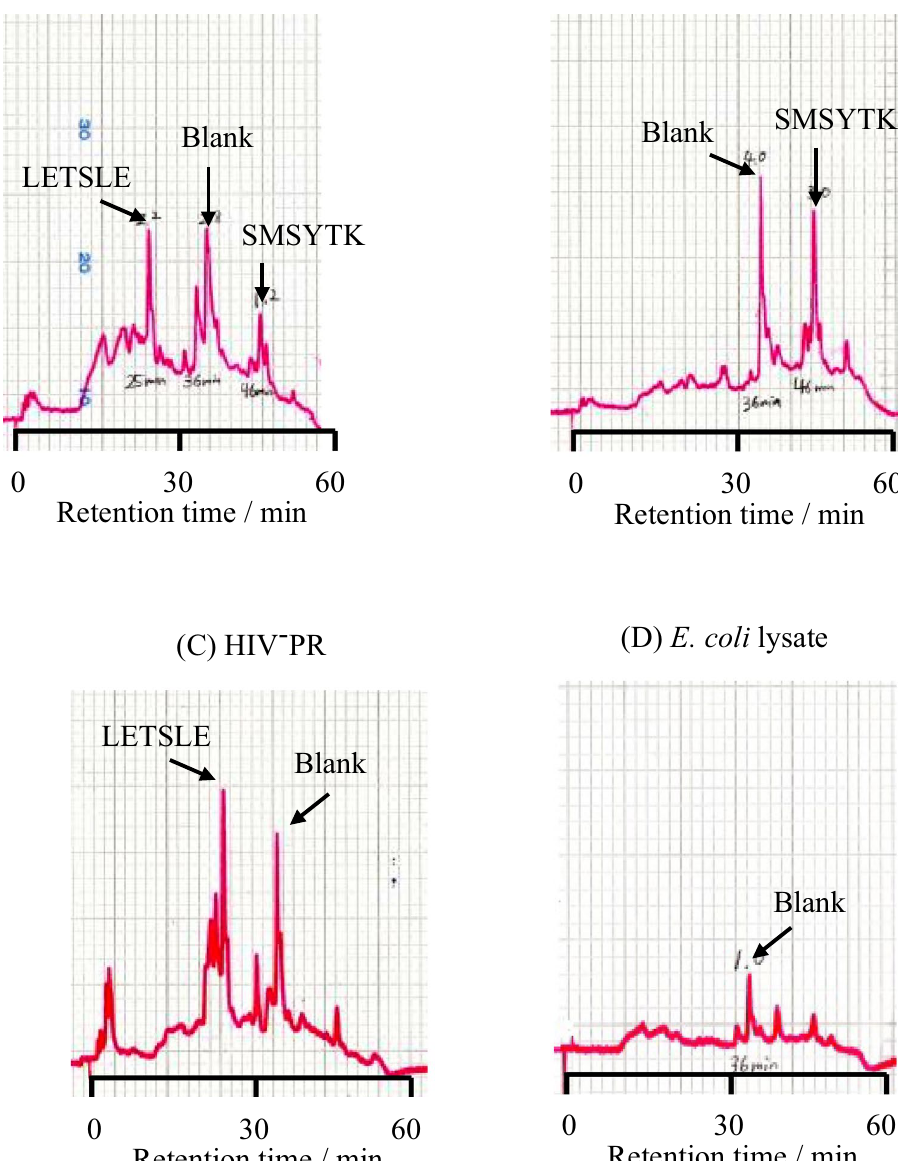
Figure 4. Simultaneous detection of HCV-PR and HIV-PR activities. A substrate mixture was incubated with ( A ) both HCV-PR and HIV-PR, ( B ) HCV-PR, ( C ) HIV-PR or ( D ) E. coli lysate without virus proteases. The enzymatic products of SMSYTK and LETSLE were converted to FL